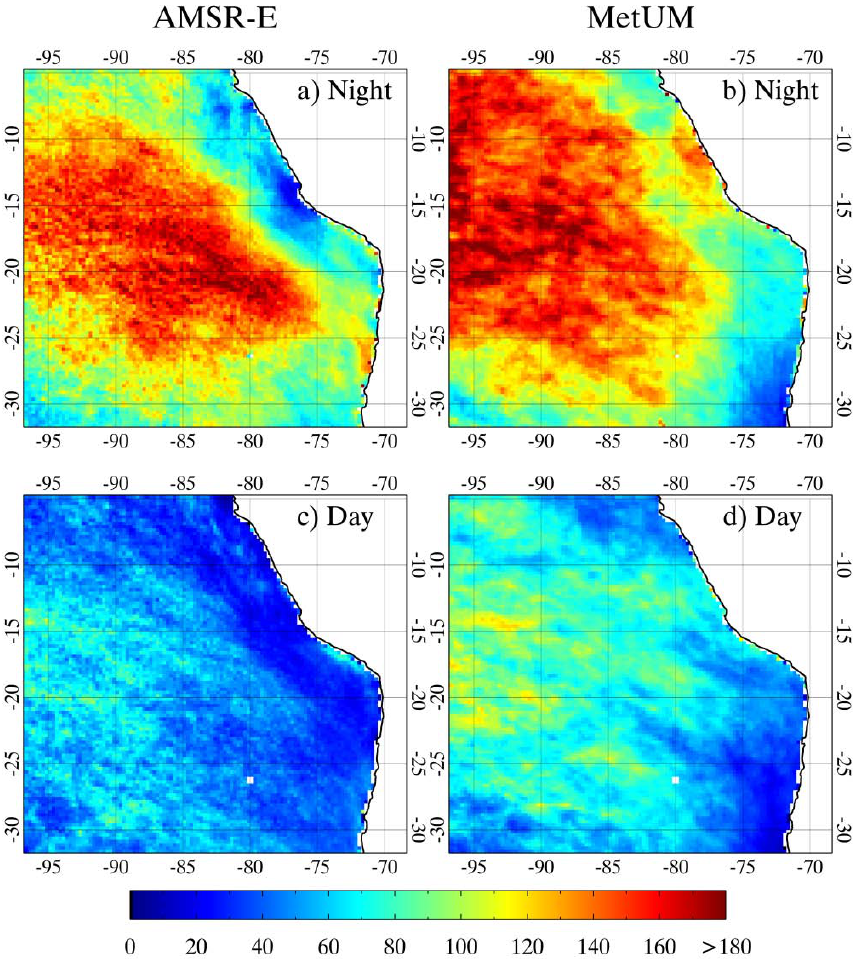
Fig. 7. Mean LWP [gm − 2 ] at the time of the AMSR-E satellite descending (night) and ascending (day) passes for the period 14 October to 19 November 2008. The AMSR-E data are shown in panels (a) and (c) and the MetUM forecast data in panels (b) and (d)